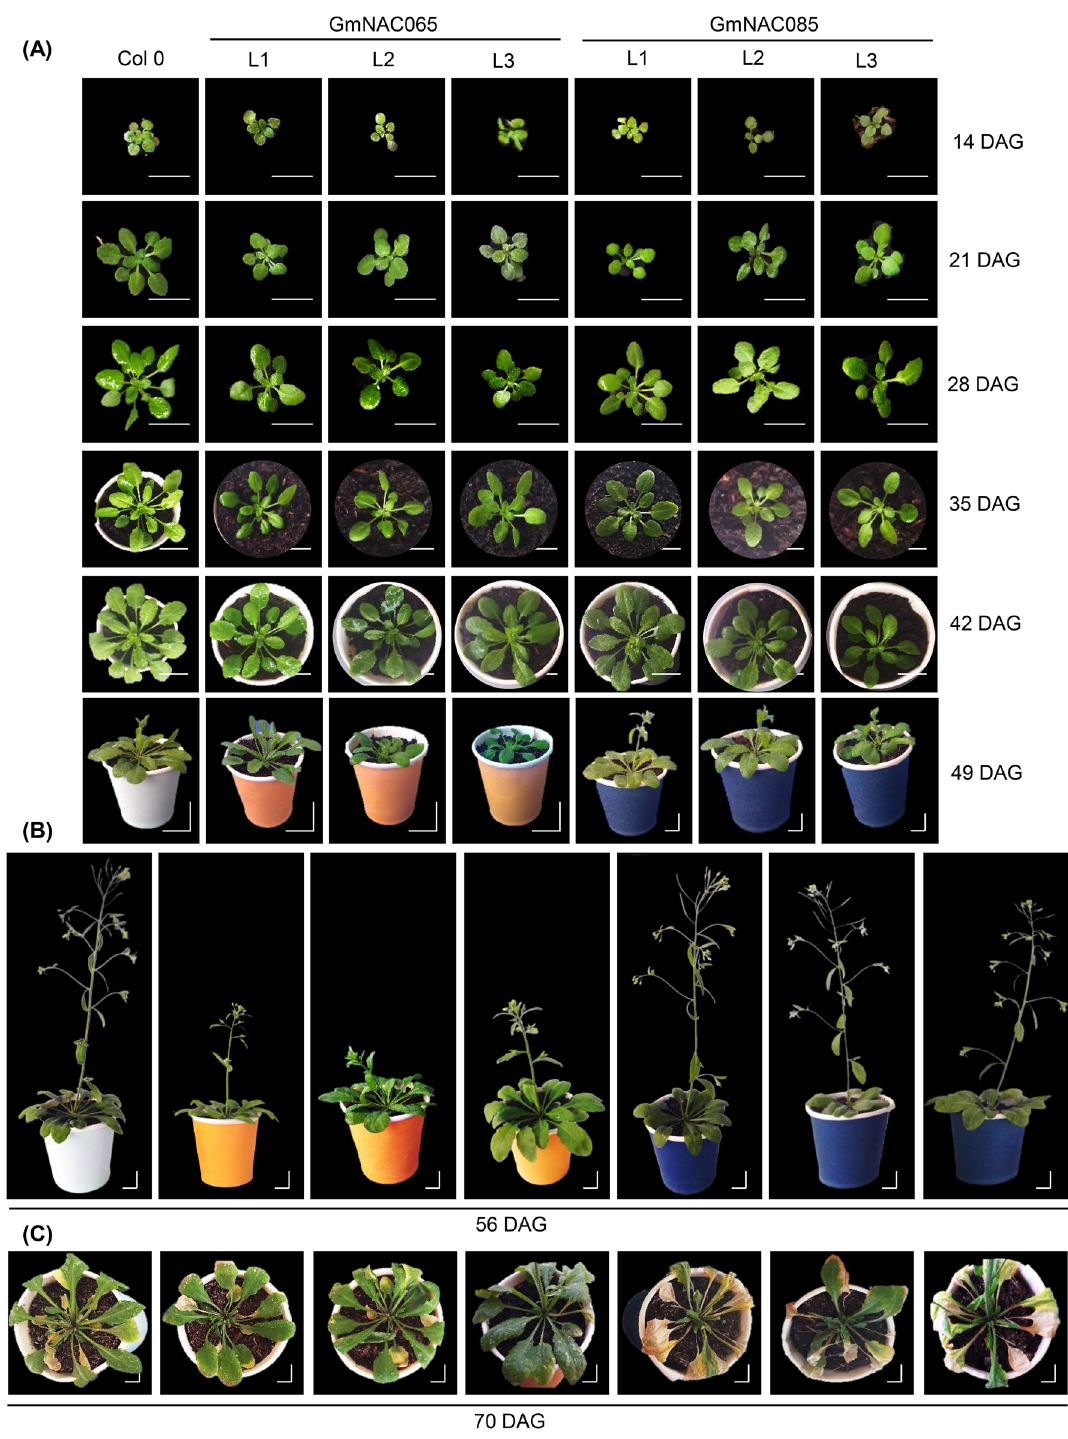
Figure 4. Phenotypical characterization of three homozygous independent lines of Arabidopsis overexpressing GmNAC065 and GmNAC085 . ( A ) Phenotypical characterization of GmNAC065-OX and GmNAC085-OX lines (L1, L2 and L3) during the vegetative stage and the onset of the reproductive stage. Plants were analyzed up to 42 days after germination (DAG) in the vegetative stage and up to 56 DAG in the reproductive stage. 49 DAG was considered the onset of the reproductive stage, hallmarked by the inflorescence’s emergence. ( B ) Phenotypical characterization of GmNAC065-OX and GmNAC085-OX lines in the reproductive stage. ( C ) Phenotypical characterization of transgenic Arabidopsis lines during senescence. All experiments were performed with plants under normal development, cultivated in a growth chamber with standard settings. Scale bars = 0.5